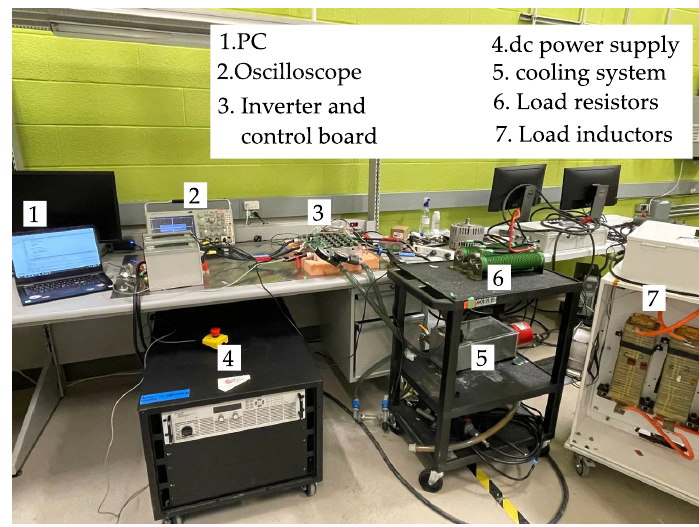
Figure 16. The experimental setup of the 3-L ANPC. Table 4. Experimental parameters.